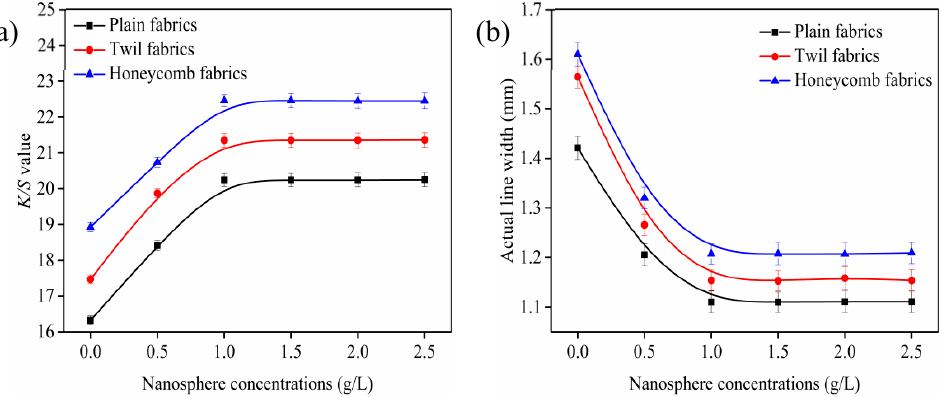
Figure 4. Effect of cationic nanospheres on color strength ( K / S ) values ( a ) and outline sharpness ( b ), fabric was printed with cyan as a rectangle pattern of 80 × 150 mm and lines of 1 mm. All the pickup of fabrics were 70 ± 1% and steaming temperature was 102 ± 1 °C.